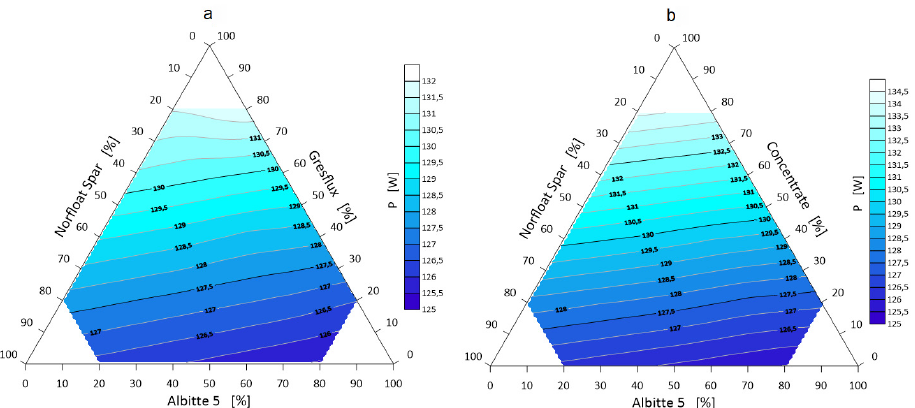
Figure 13. Thermal power P of the Greslux ( a )/Concentrate ( b ) –Albitte 5–Norfloat Spar three-com- ponent mineral system. component mineral